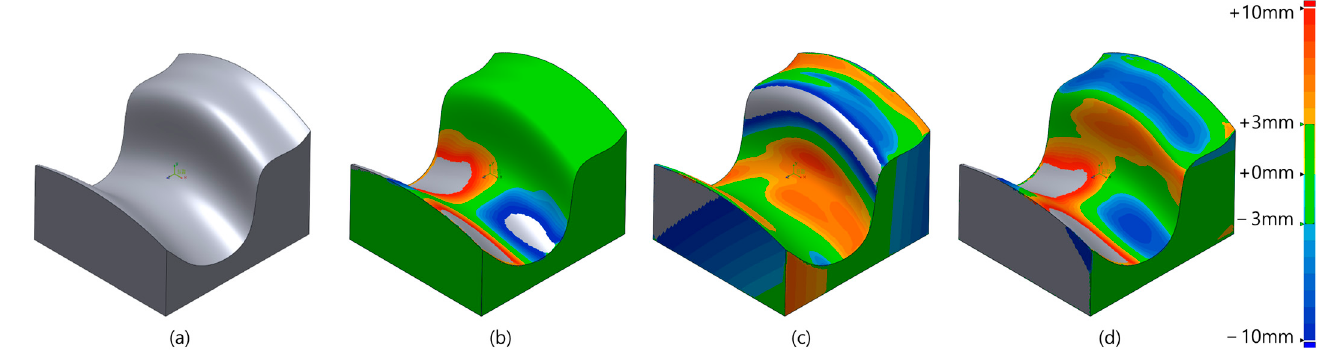
Figure 7. 3D Contour graphs of surface errors; ( a ) target surface; ( b ) CNC milling; ( c ) uniform slicing; ( d ) adaptive slicing.